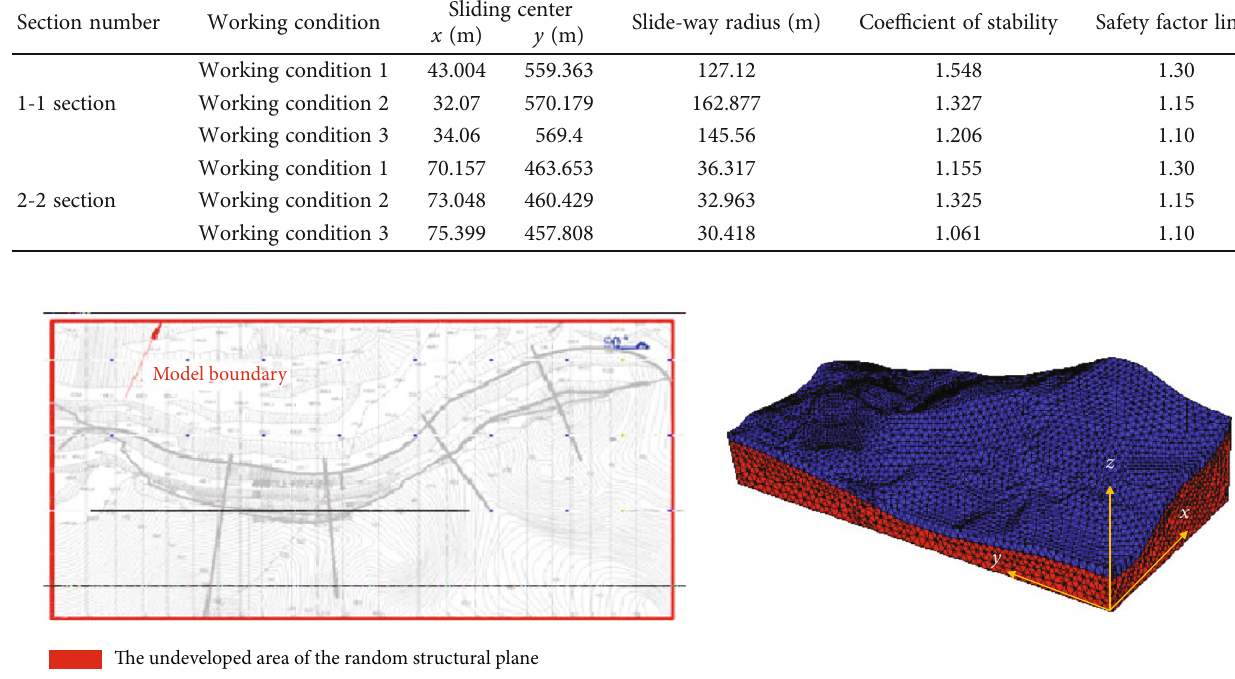
Table 3: Calculation results of the seepage stability of the slope sections.